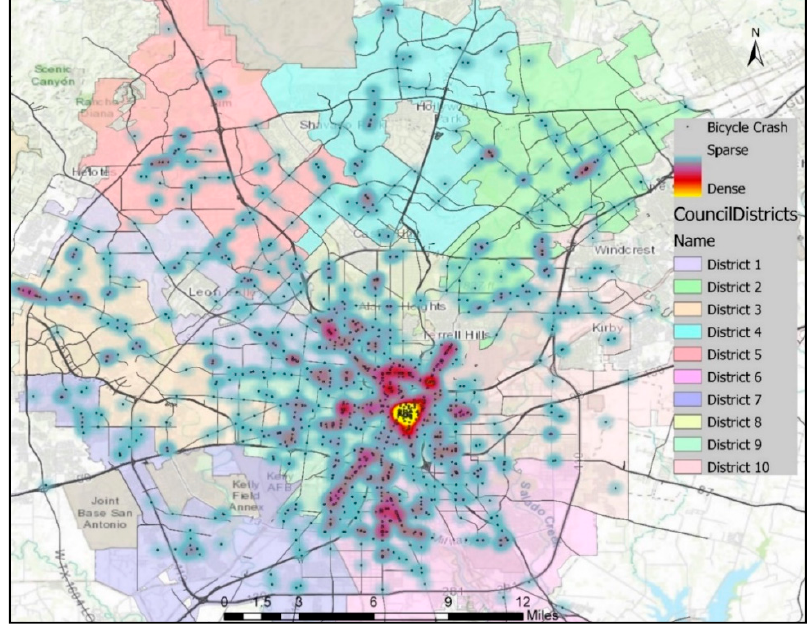
Figure 1. Heatmap of bicycle crashes in San Antonio based on crash density.